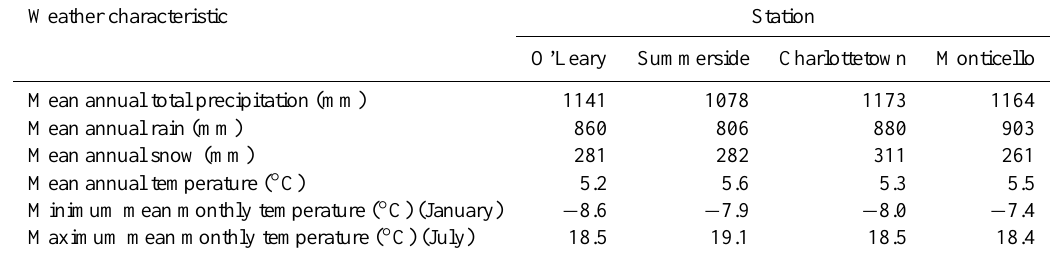
Table 2. Weather for Prince Edward Island (meteorological data for the 1971–2000 period). See Fig. 1 for locations of the weather stations. Weather characteristic